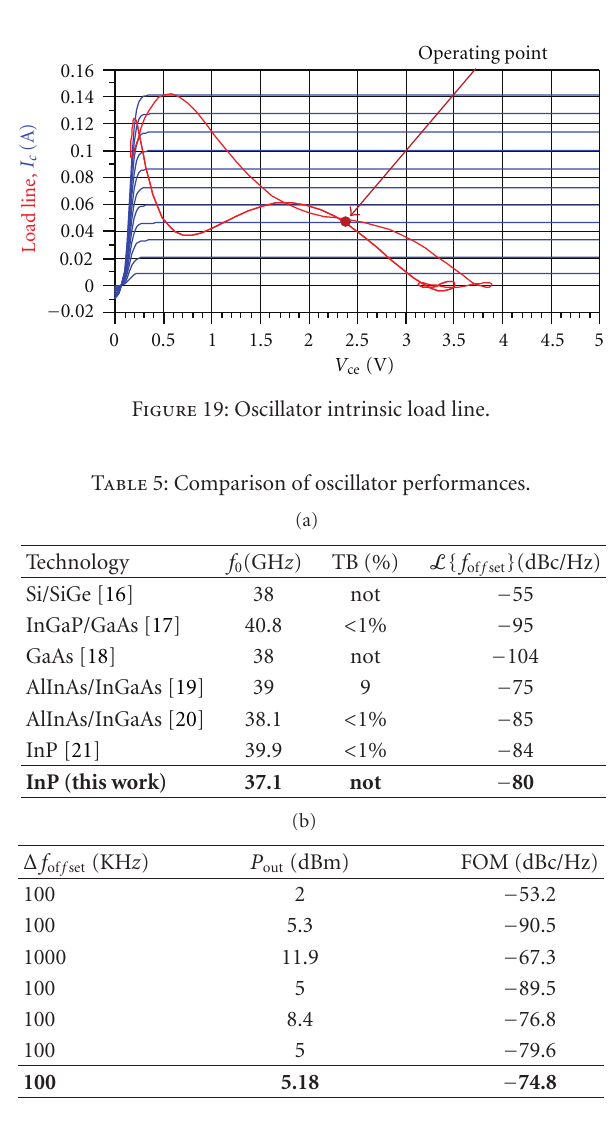
Figure 18: Intrinsic time domain waveform of I c current and V ce voltage.